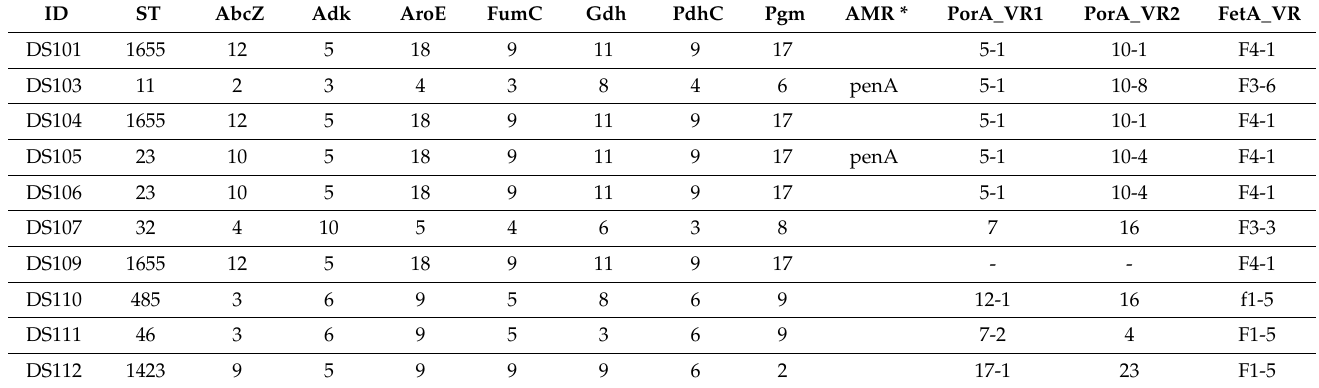
Table 4. Genotyping of N. meningitidis sequenced from dried clinical specimens through targeted DNA